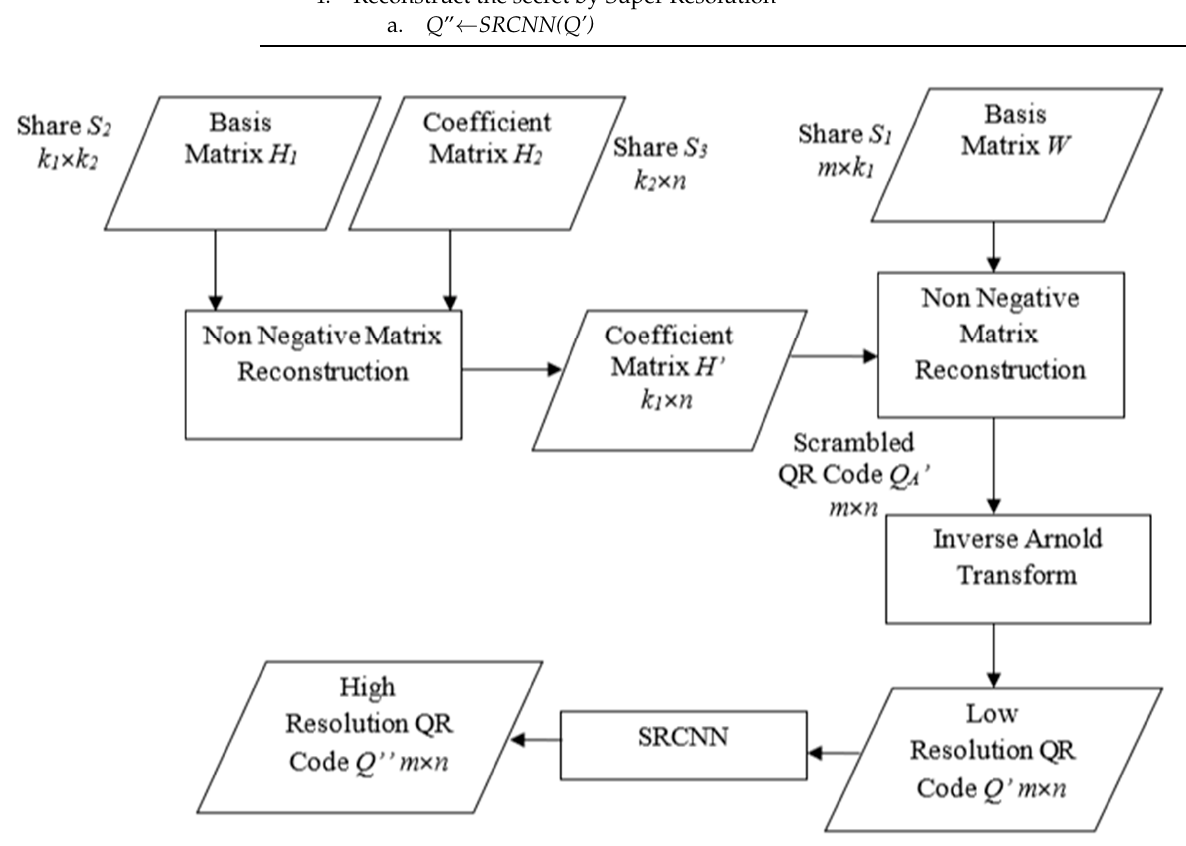
Figure 6. Secret-image reconstruction.